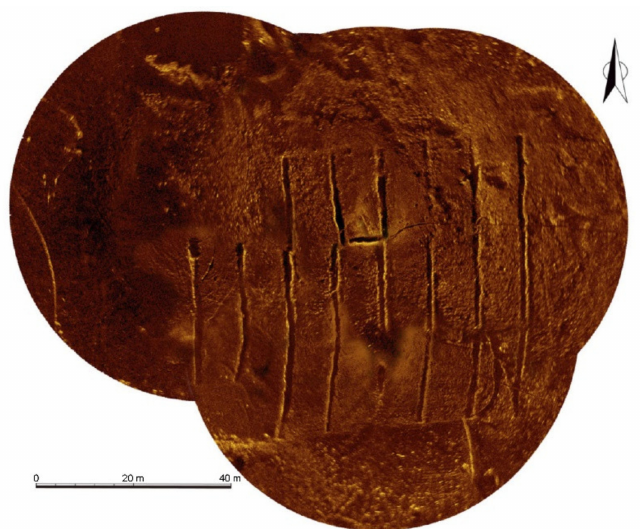
Figure 9. Reflector installed on the seafloor.